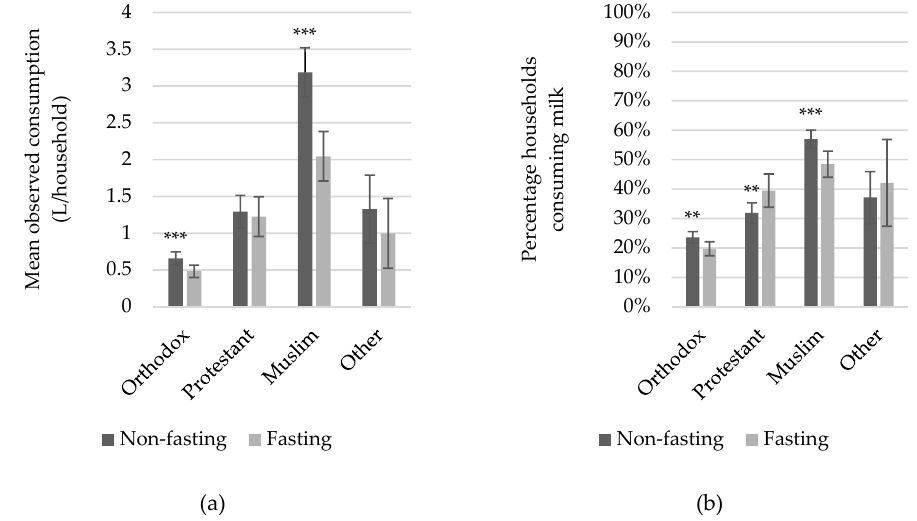
Figure 1. ( a ) Average observed milk consumption and ( b ) proportion of households consuming milk across religious groups during Orthodox fasting and non-fasting; with confidence intervals drawn at α = 0.05; *** and ** represent statistical significance at a probability of less than 1% and 5%, respectively. Table 1. Descriptive household characteristics of consuming and non-consuming Orthodox households during Lent. Mean (std.